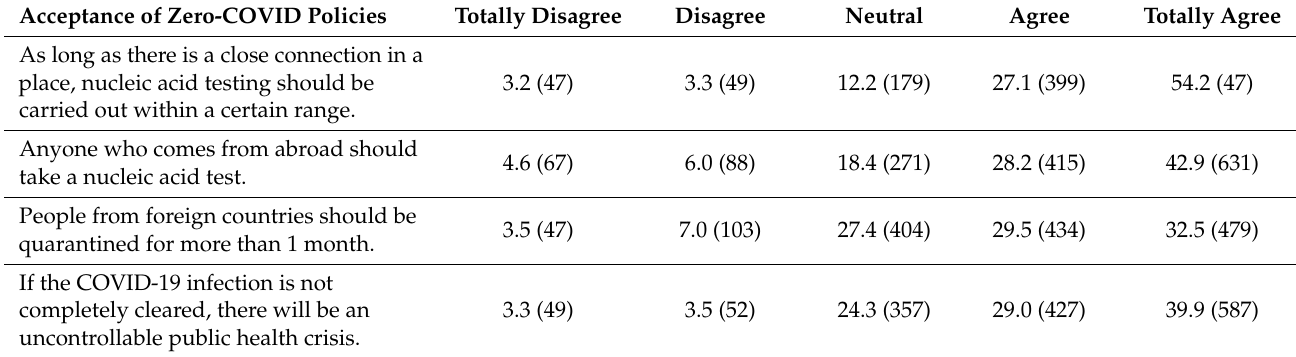
Table 8. Participants’ zero-COVID policy endorsement ( n = 1472).